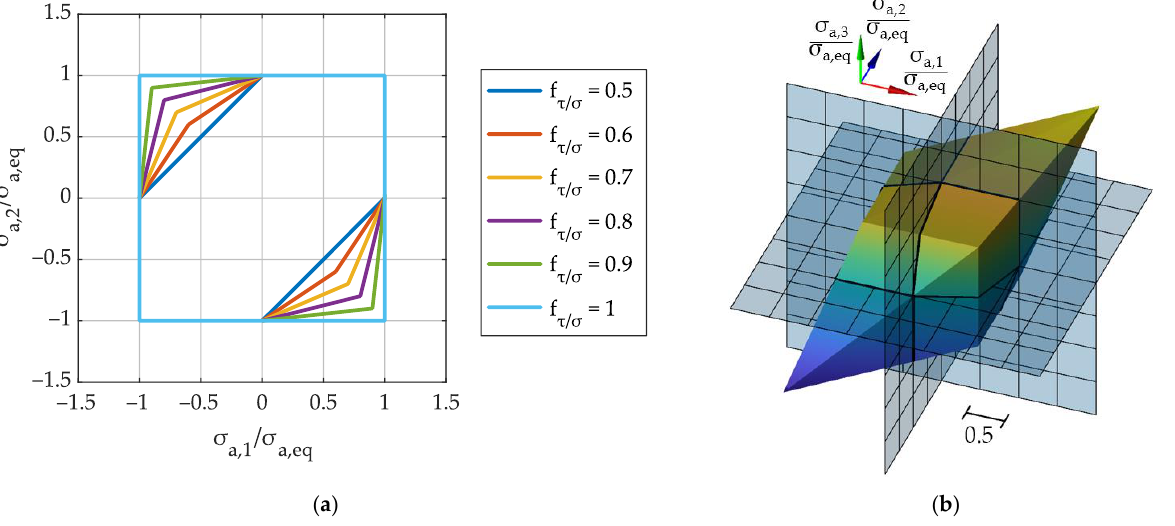
Figure 3. Strength hypothesis according to El-Magd for ( a ) different values for f τ σ ⁄ and plane stress states, σ 3 = 0 , and ( b ) f τ σ ⁄ = 0.75 and triaxial stress states.